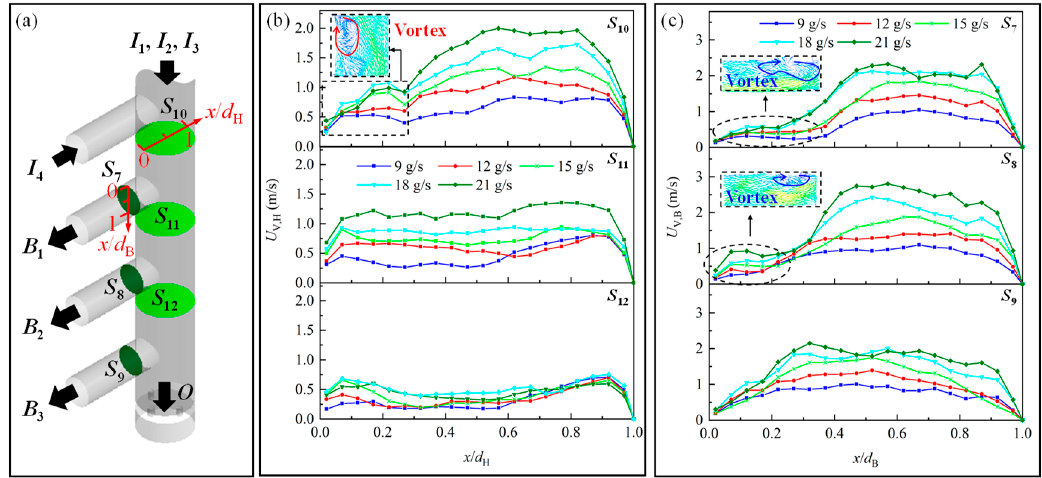
Figure 8. ( a ) Instructions and the vapor velocity distribution in ( b ) header and ( c ) branch outlet.